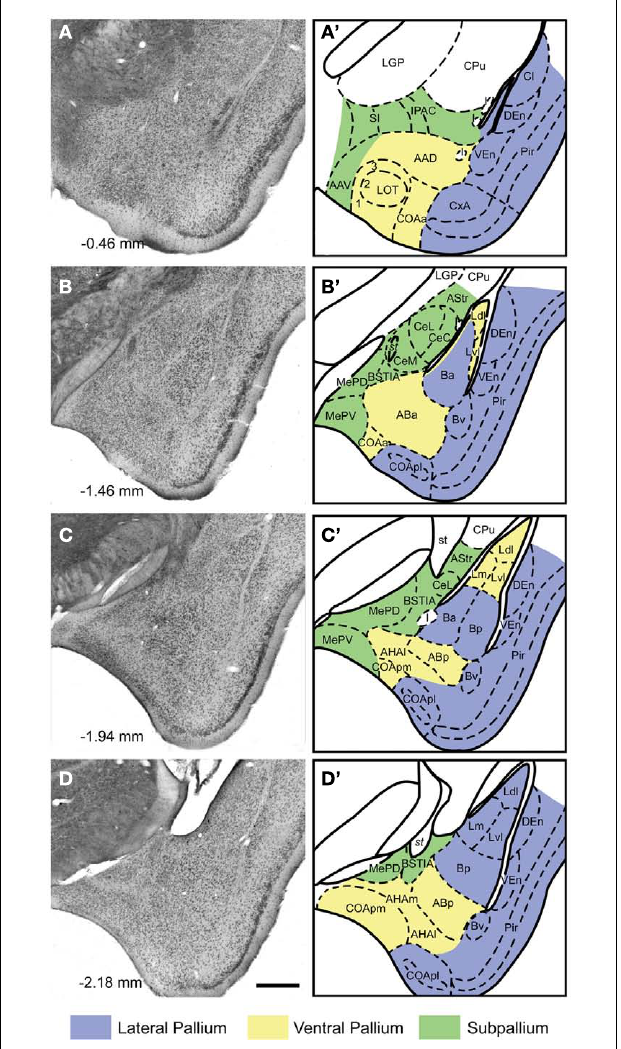
FIGURE 1 | Cytoarchitecture of the amygdaloid complex of the mouse Nissl-stained frontal sections (A–D) through the amygdala of the mouse (A rostral, D caudal) with indication of the antero-posterior level relative to Bregma according to Paxinos and Franklin (2001) . In the right panels (A (cid:2) –D (cid:2) ) , the boundaries between the different nuclei and fiber tracts are delineated in schematic drawings of the same sections.The embryological origin (subpallial, lateropallial, ventropallial) of the different amygdaloid structures is also indicated. For abbreviations, see list. Calibration bar = 400 μ